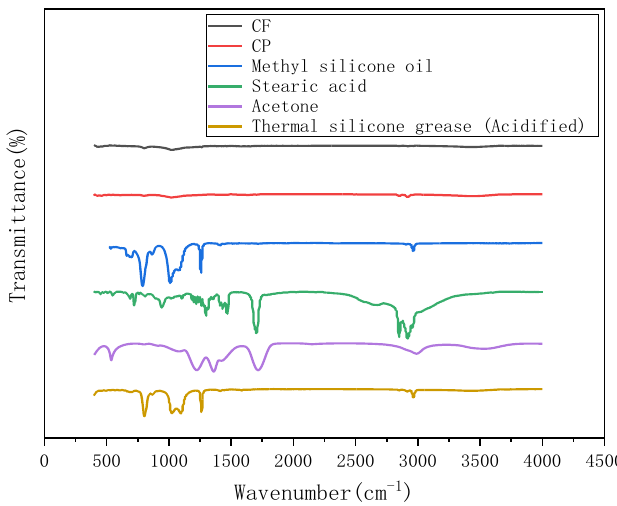
Figure 11. FTIR spectrum of acidified TSG containing CP / CF thermally conductive filler and its components.